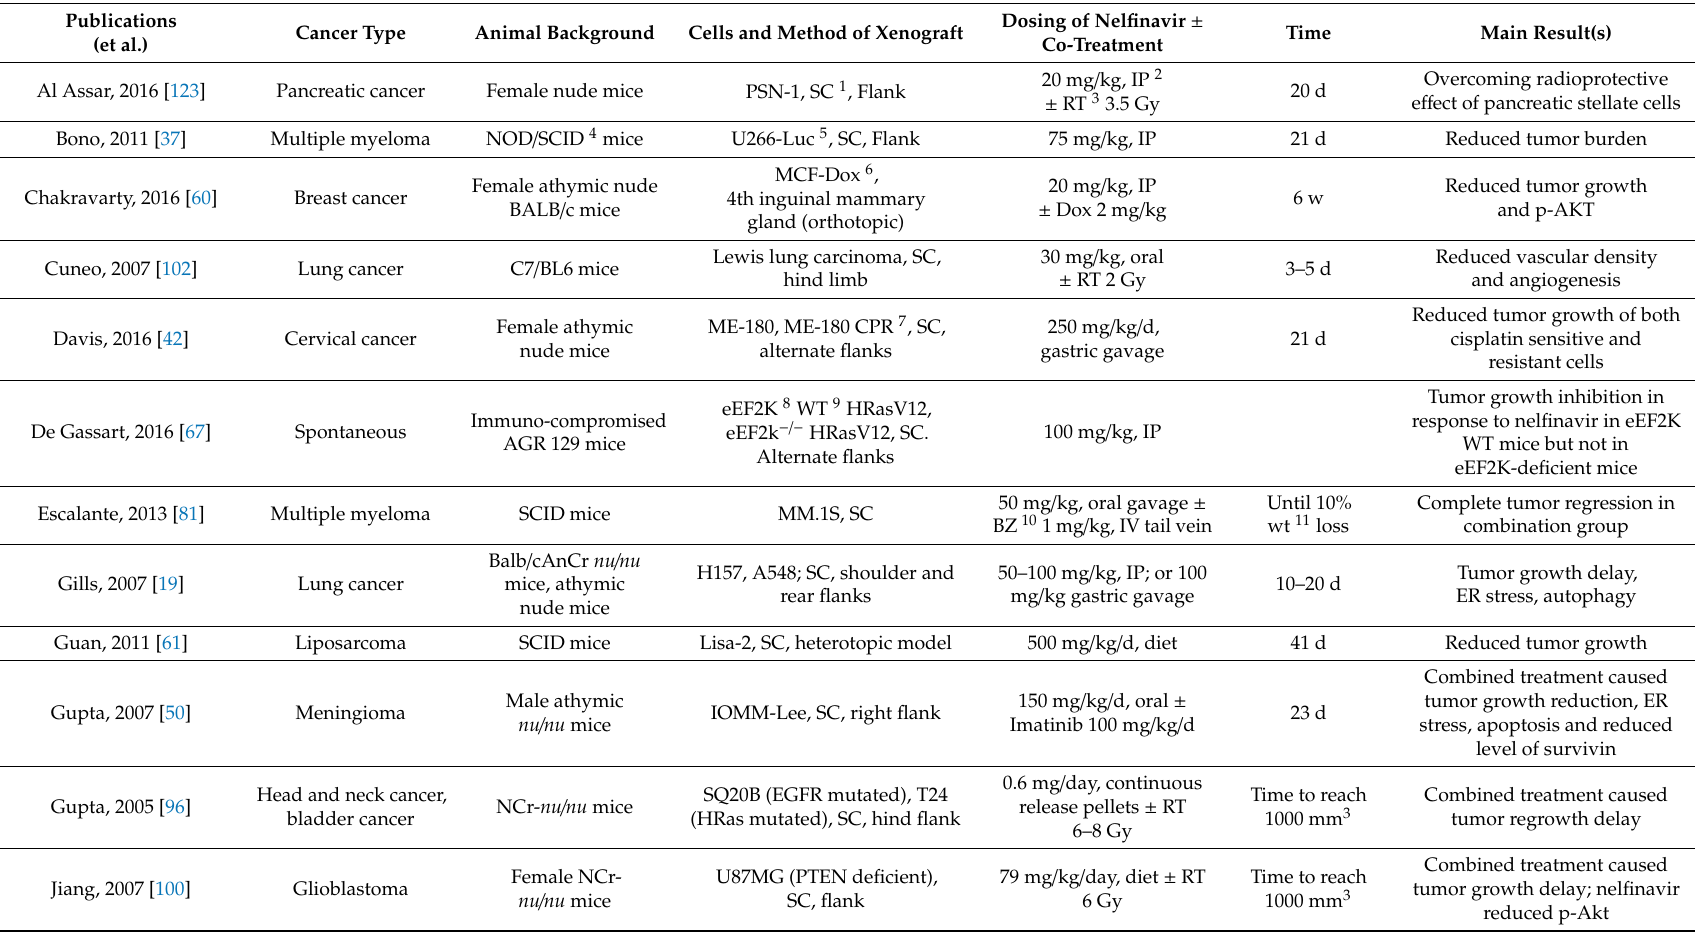
Table 1. Anti-tumor e ff ects of nelfinavir in animal